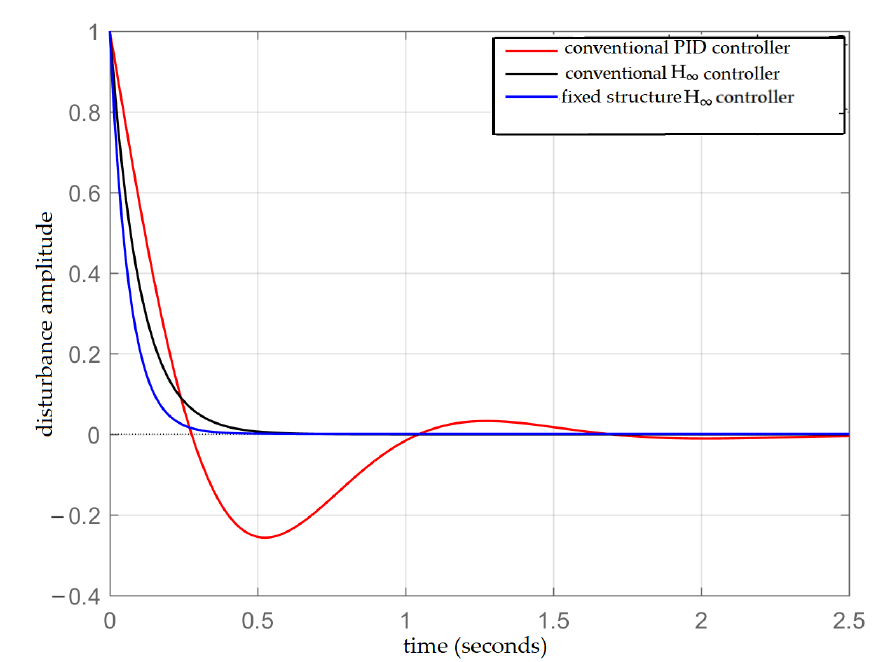
Figure 11. Step disturbance rejection comparison among all three